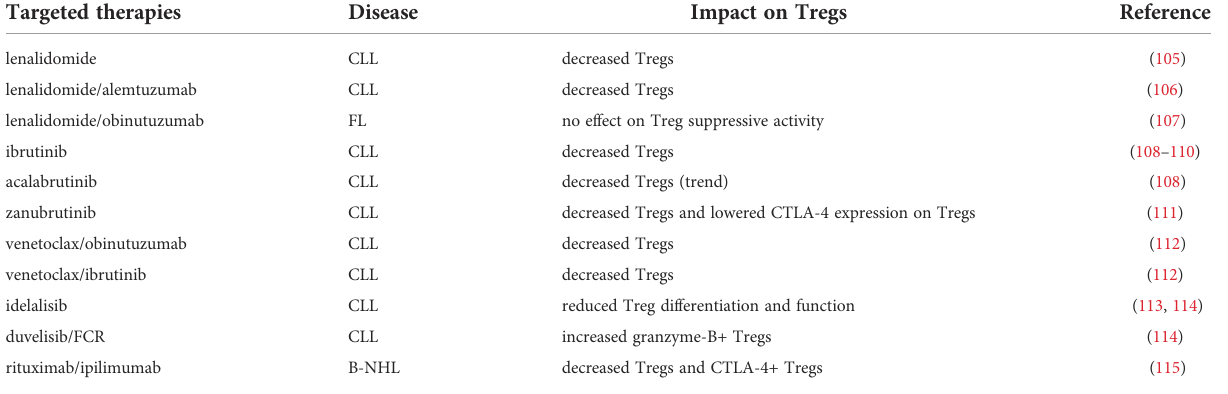
TABLE 2 Impact of targeted therapies on Tregs in patients with B-cell lymphoid